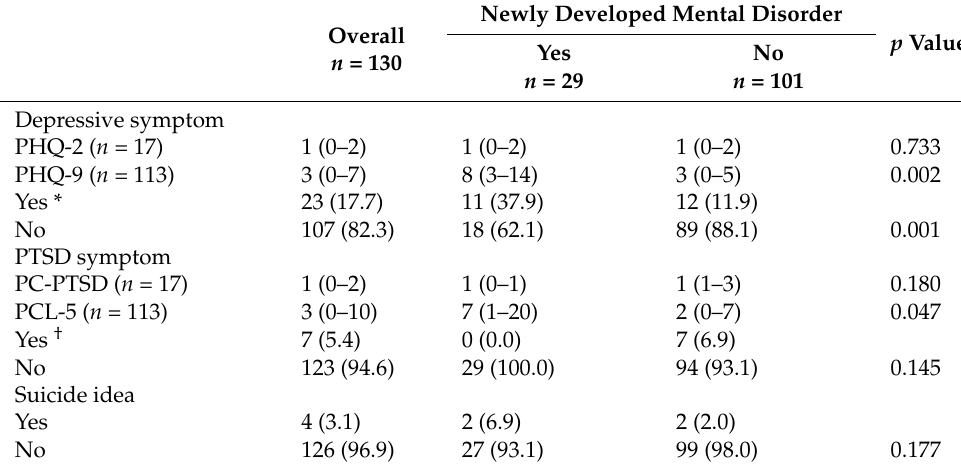
Table 2. Baseline psychological assessment results of the patients.